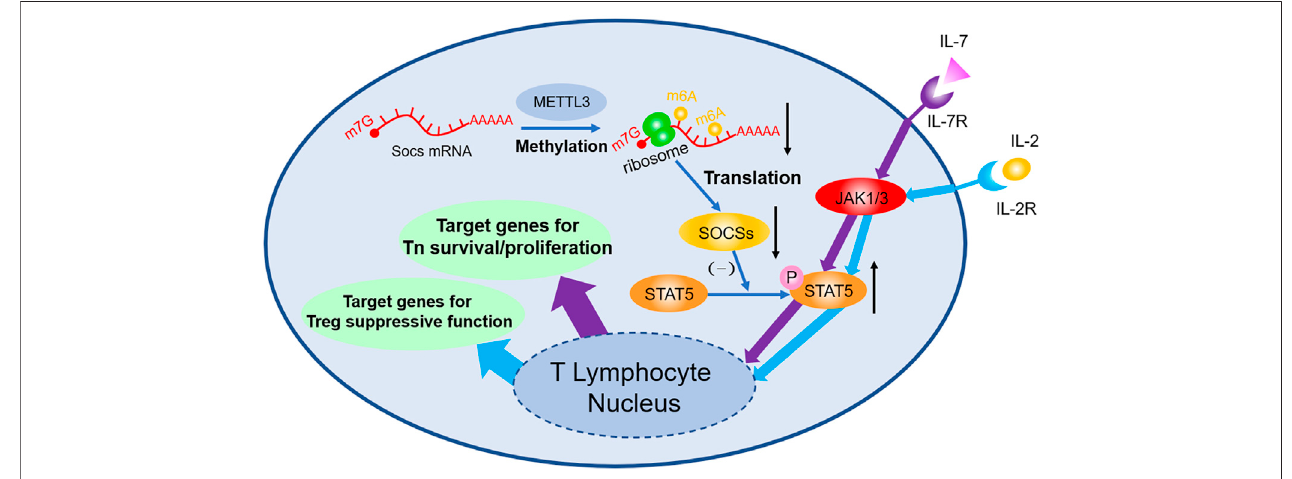
FIGURE 1 | m 6 A decoration contributes to the regulation of Tn differentiation and Treg function both through JAK-STAT5 pathway. m 6 A modi fi cations in Soc1 , Soc3 , and Cish mRNA accelerate their degradation, thus decreasing the expression of SOCS. As a consequence, through the JAK/STAT5 pathway, IL-7 induced differentiation of Tn and IL-2 induced suppressive function of Treg are both in fl uenced afterwards.